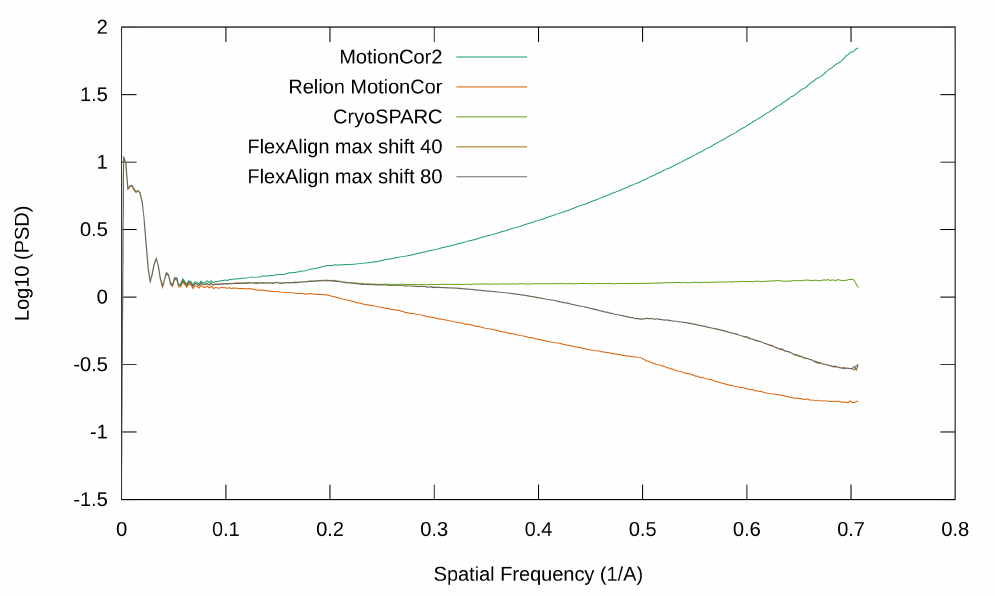
Figure 16. Radial average of the PSD of the produced micrograph using EMPIAR